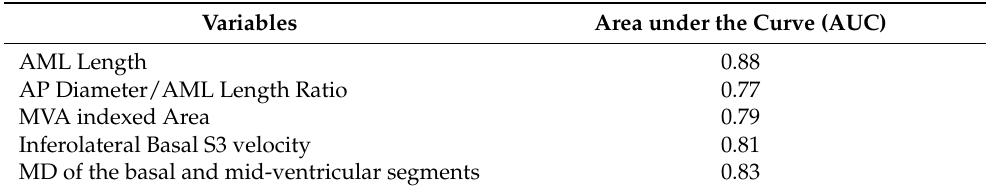
Table 4. Area under the curve (AUC) of ROC curves calculated for each significantly different variable between the two